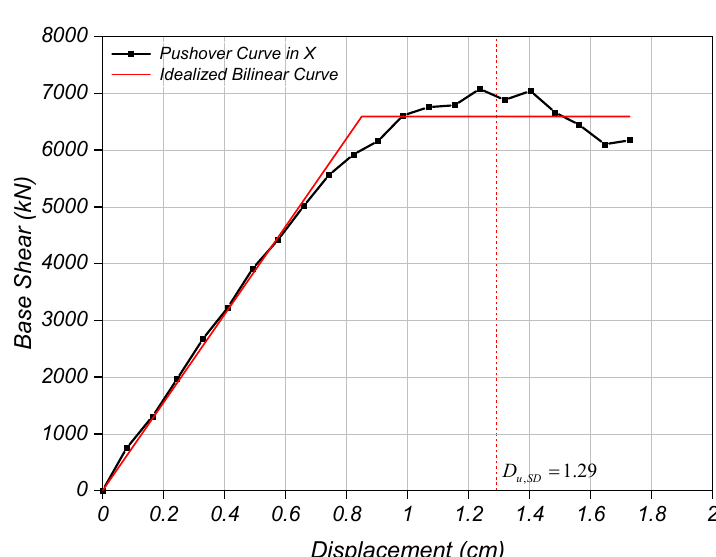
Figure 16. Pushover curve of seismic analysis n.1, direction X